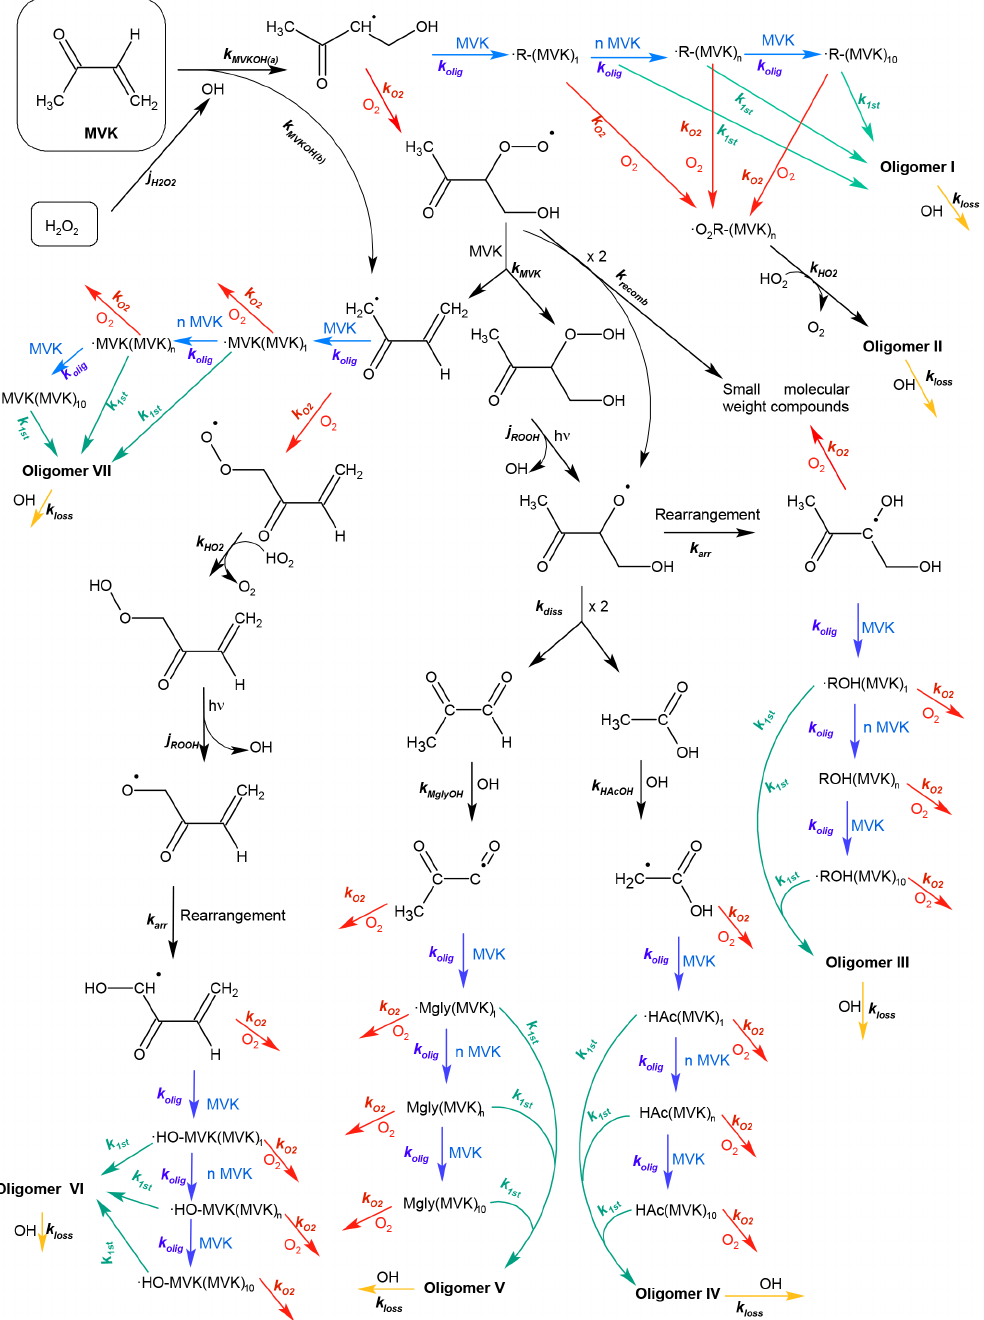
Figure 1. Chemical mechanism, constrained by laboratory studies for different conditions [MVK] 0 , [H 2 O 2 ] 0 . Reactions that are marked by the same color are assumed to occur with identical rate constants ( k olig , k O